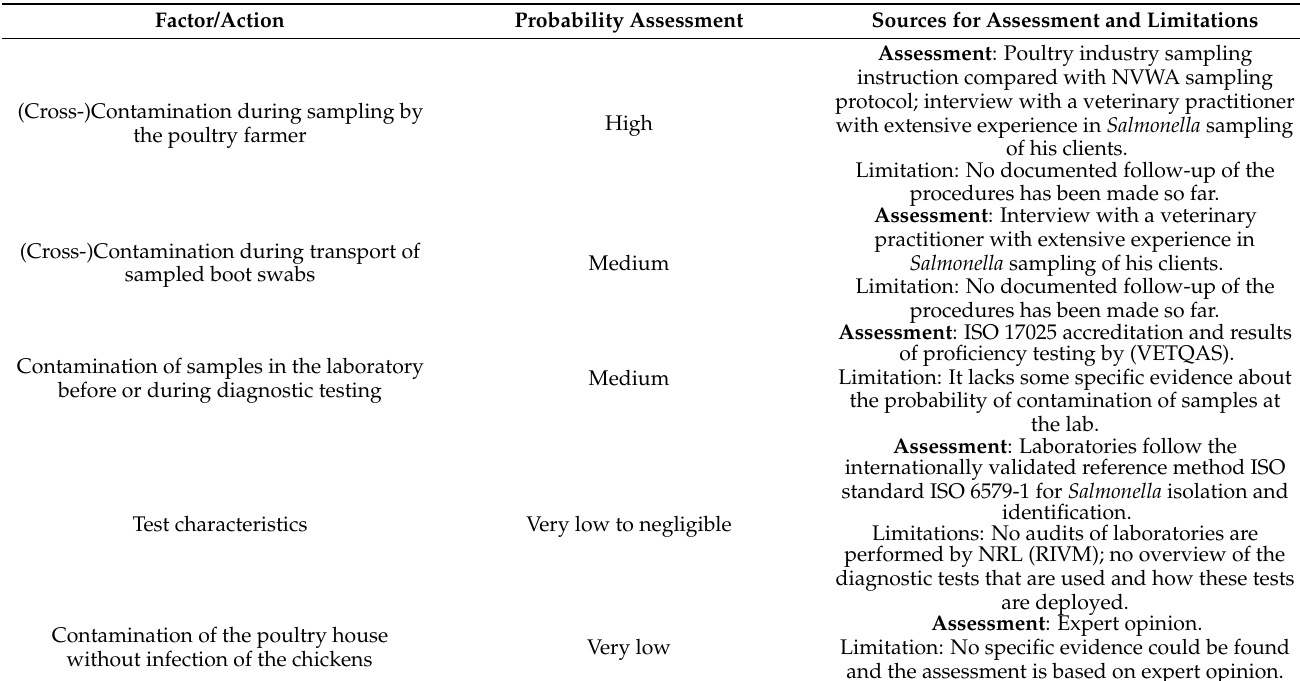
Table 4. Summary of assessed factors/actions considered to be associated with an incorrect positive test result during routine Salmonella